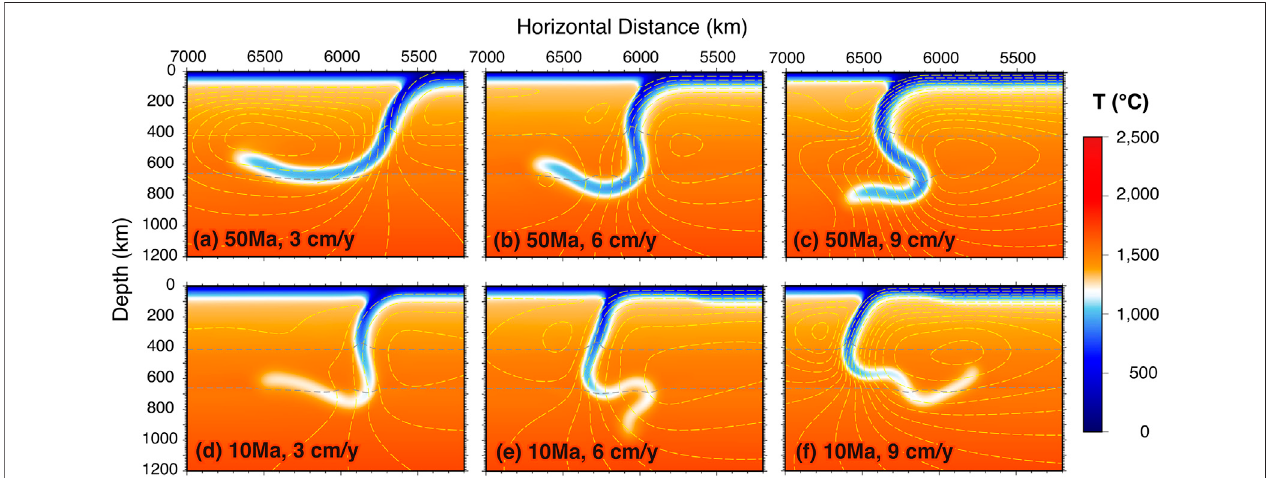
FIGURE 3 | Thermal structures simulated by six runs with different pushing velocities (V push ) (from left to right, 3, 6, and 9 cm/year) and thermal ages of the subducting microplate (50 Myr at top row and 10 Myr at bottom row). Grey dashed lines represent the 410 and 660 km depth boundaries. Thin yellow dashed lines are streamfunctionsofmantle fl ows(5 × 10 – 5 m 2 /sintervals).See SupplementaryFigureS3 foraschematicillustrationofthesimulationand SupplementaryVideos1 – 6 for the six simulation